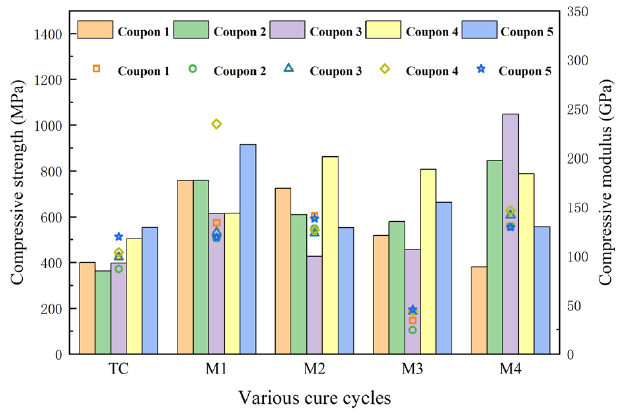
Figure 9. The 0 ◦ compressive strength and modulus of laminates cured by different cure cycles. Figure 9. The 0° compressive strength and modulus of laminates cured by different cure cycles.